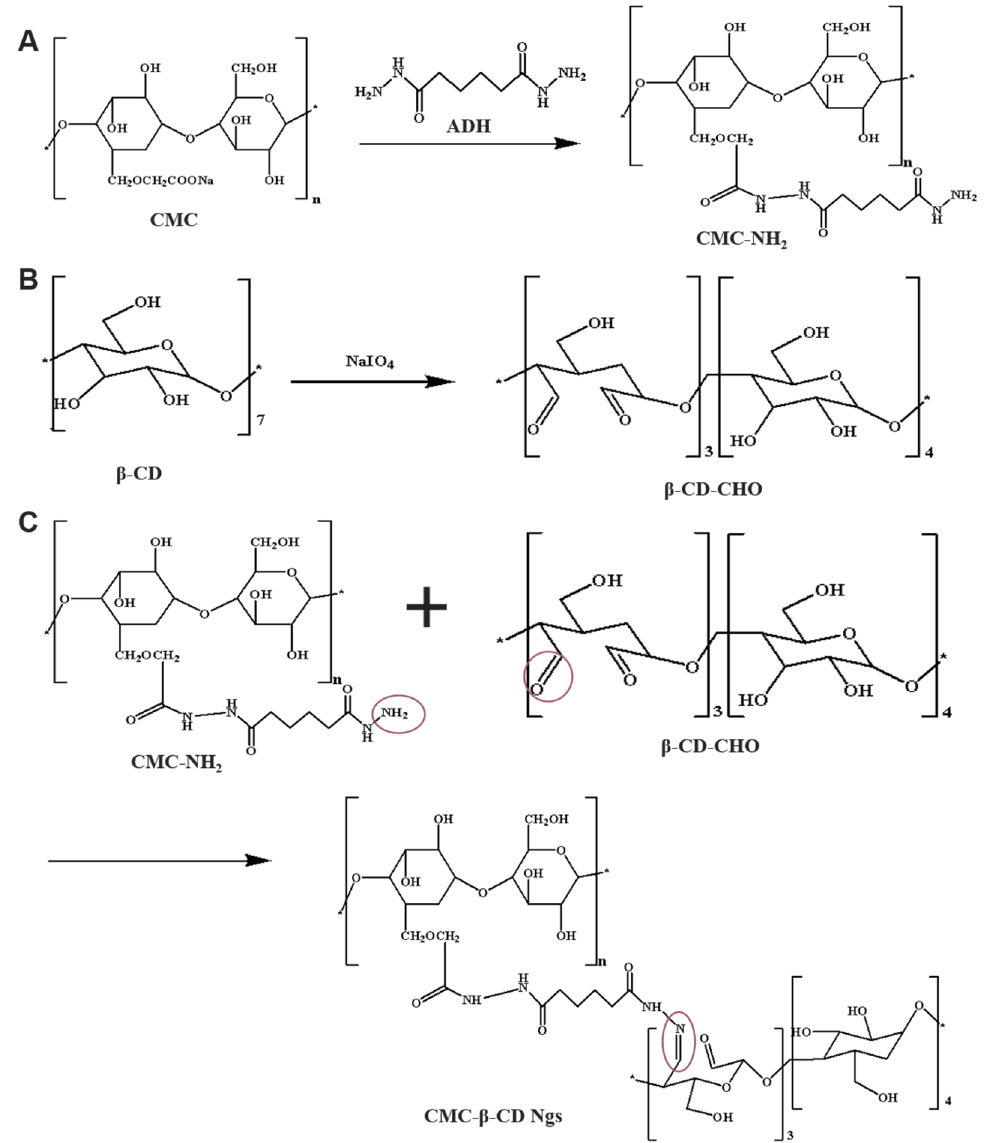
Figure 2. Synthsis of CMC- β -CD Ngs. ( A ) Schematic diagram of adipic acid dihydrazide modification CMC reaction. ( B ) Schematic diagram of the reaction of sodium periodate to oxidize β -CD. ( C ) Schematic diagram of the amide reaction of CMC-NH 2 and β